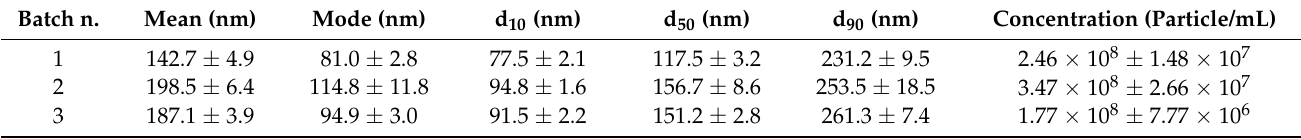
Table 3. Particle size distribution and concentration of batch 1 and 2 (mean values ± standard deviation, n = 3). Batch